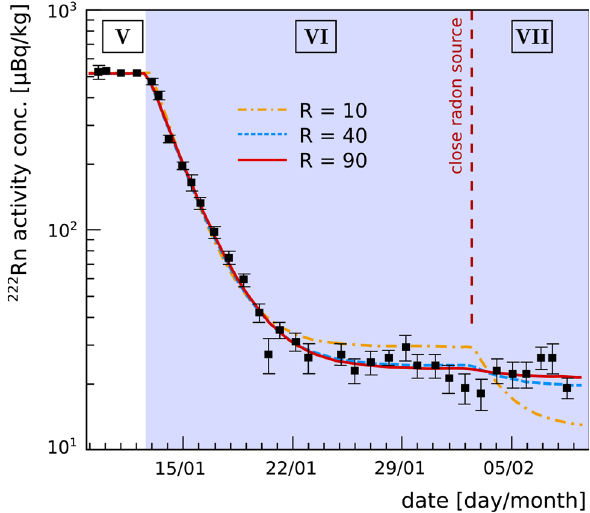
Fig. 6 222 Rn activity fit to phases V–VII after constraining the auxil- iary emanation source c s ( red line ). For comparison, the fit is repeated while keeping the reduction factor R fixed at 10, 40 and